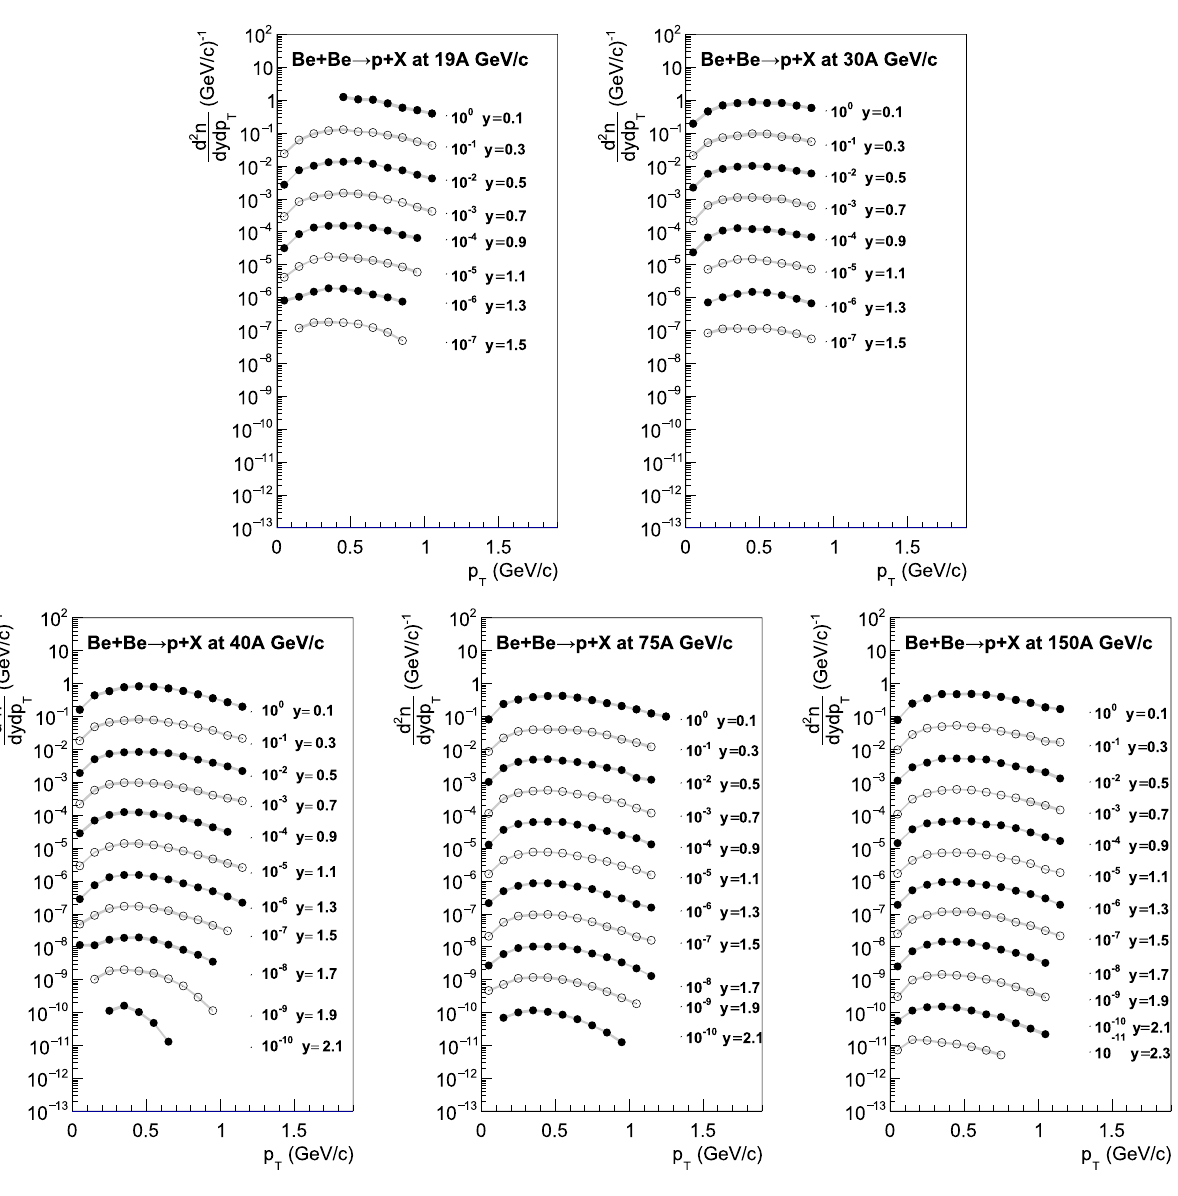
Fig. 24 Transverse momentum spectra in rapidity slices of protons produced in the 20% most central Be+Be collisions. Rapidity values giveninthelegendscorrespondtothemiddleofthecorrespondinginter-